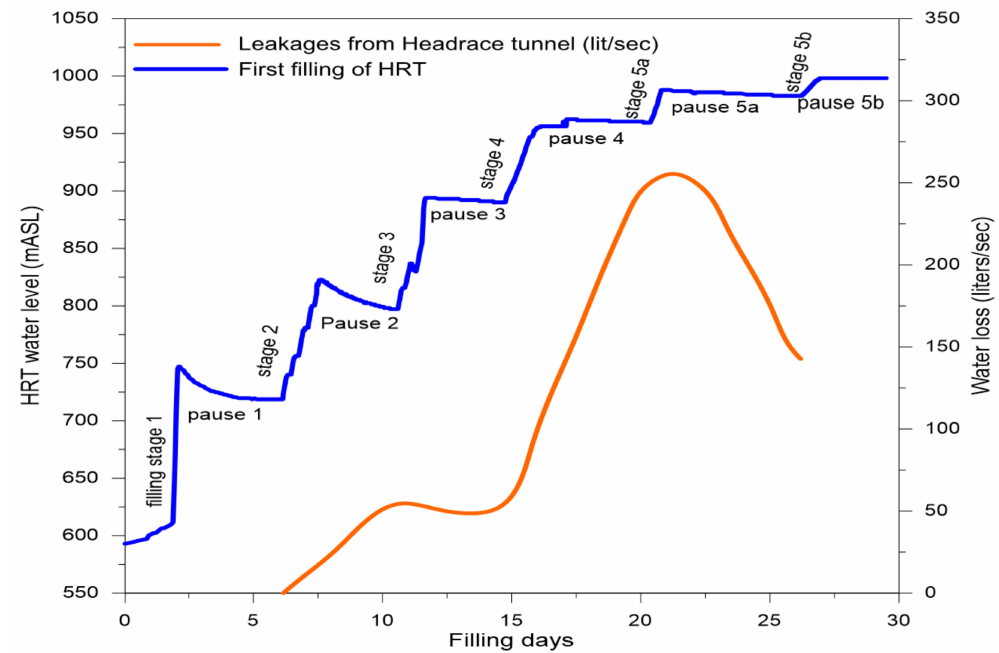
Figure 12. Filling stages and water loss during headrace tunnel